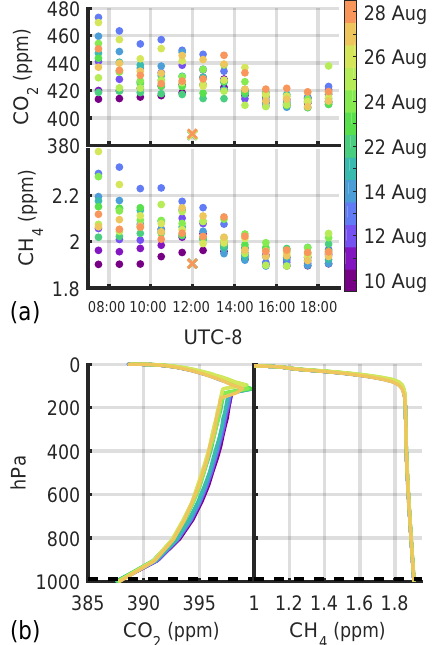
Figure 6. (a) Diurnal variation of in situ DMFs measured near the surface at Caltech on the days of TCCON to mFTS comparisons. A priori surface values are marked by an “x” at noon. (b) GGG2014 a priori profiles used in the retrievals, with lower CO 2 and CH 4 than was measured near the surface. Surface pressure is indicated by the dashed line.